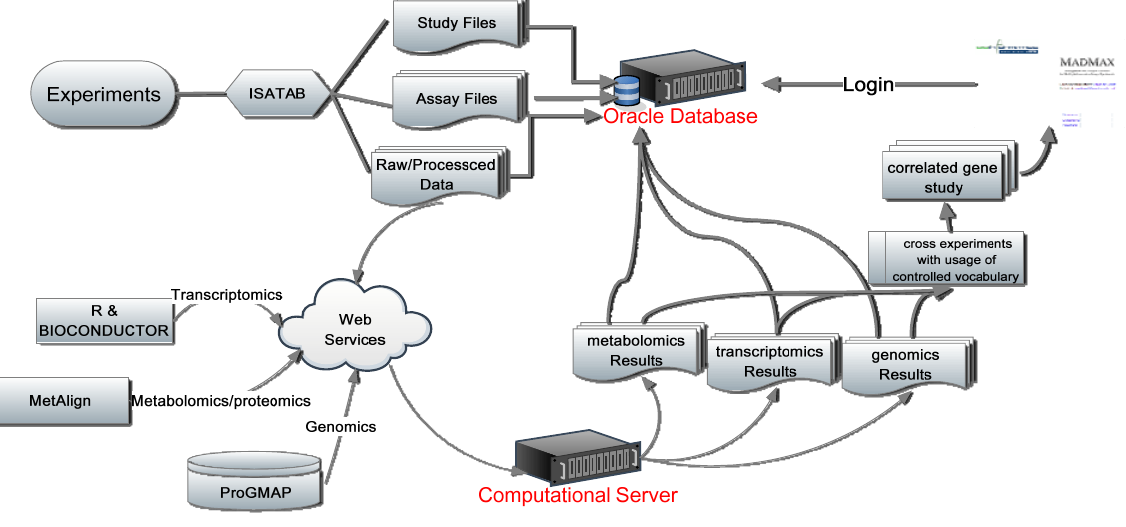
Figure 1: Architecture and pipeline of